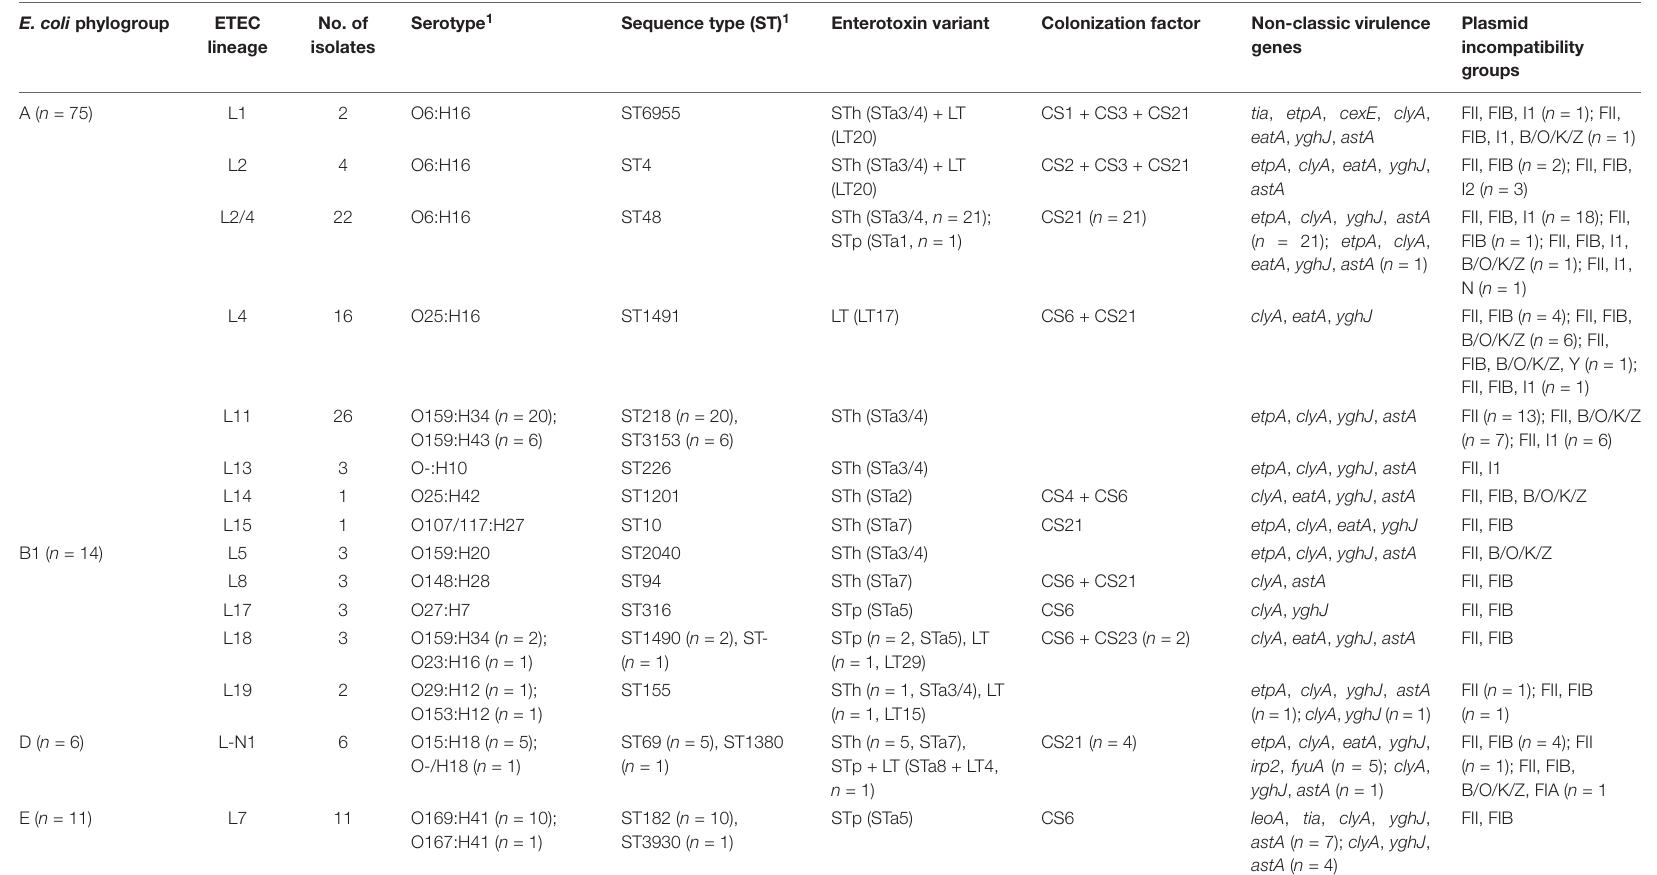
TABLE 1 | Classification, enterotoxin, and colonization factor distribution of 106 ETEC isolates in Shenzhen,